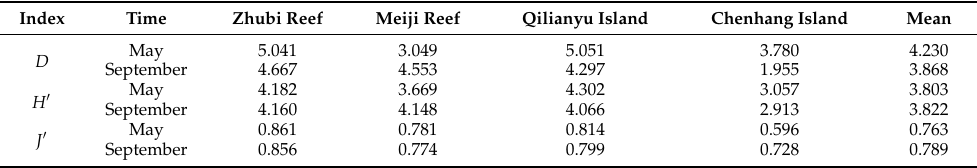
Table 4. Richness, diversity and evenness indices of fish assemblages in Zhubi Reef, Meiji Reef, Qilianyu Island and Chenhang Island in May and September.